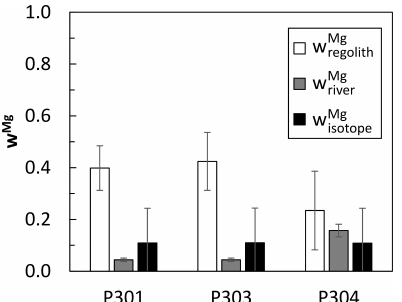
Figure 5. Comparison of the relative weathering flux derived from Mg isotopes ( w Mg , Table S4b), dissolved river loads ( w Mg , Ta- isotope river ble S4b), and net solubilisation fluxes ( w Mg , Table S4b) for the regolith individual Providence Creek sub-catchments. The ca. 4-fold higher w Mg of the smallest watershed P304 compared to the larger wa- river tersheds P301 and P303 might be the result of the relatively high discharge record caused by higher baseflow (Eagan et al., 2007) for such a small watershed. For that reason we consider this catchment to be